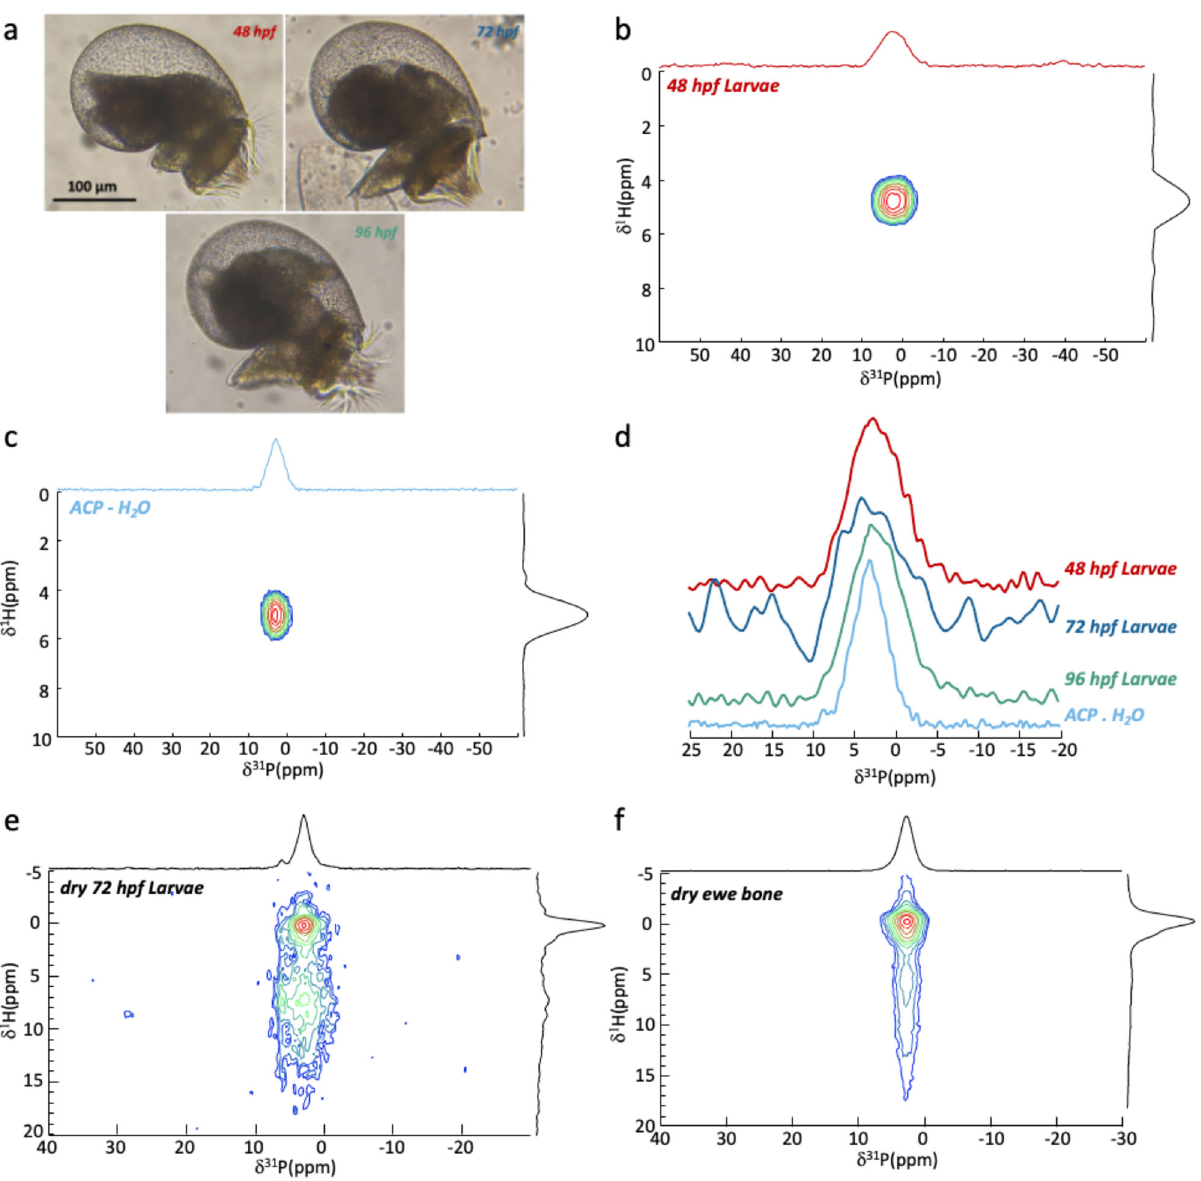
Fig. 1 Identi fi cation of and ACP-like phase in fresh hydrated H. tuberculata larvae. a Optical microscopy images of H. tuberculata at different stages of development: 48, 72, and 96 hpf. 1 H- 31 P HetCor spectra of b fresh H. tuberculata larvae at 48 hpf and c hydrated synthetic ACP (ACP.H 2 O). d Comparison of the 1 H- 31 P HetCor extracted 31 P rows of H. tuberculata and ACP.H 2 O. 1 H- 31 P HetCor spectra recorded for e dry 72 hpf H. tuberculata larvae and f